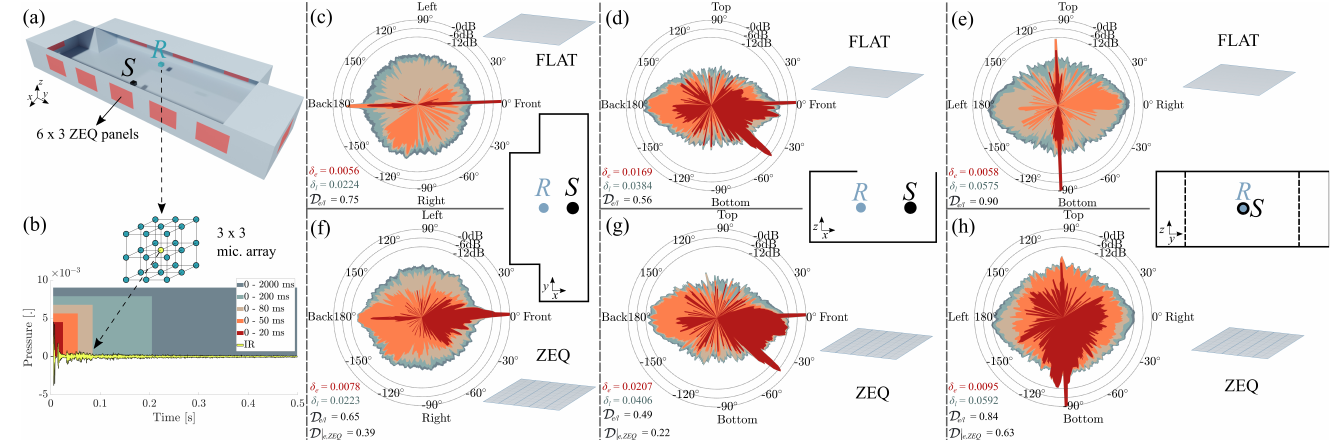
Figure 6. ( a ) Geometry of an ideal orchestra pit used in a 3D FDTD simulation. ( b ) Sample impulse response with different integration times used for the Spatial Decomposition Method (SDM). Spatio-temporal distributions of sound field energy p s (10log ) for each coordinate plane in the orchestra pit received at location R from sound source S in ( c – e ) a pit with flat 10 | | boundaries, and ( f – h ) a pit with sparsely distributed repetitions of equivalent surface impedance (ZEQ)